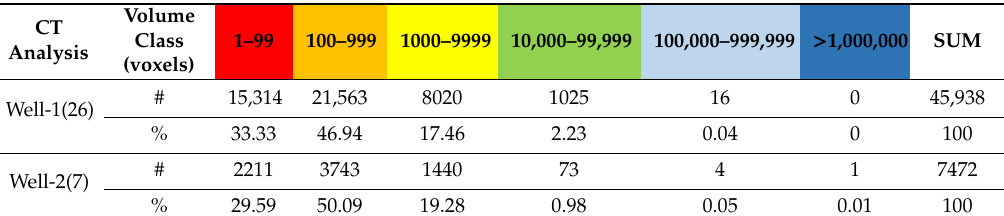
Table 4. Object size classification. Symbols: #—number of objects in volume class; %—percentage of volume class in the pore space.